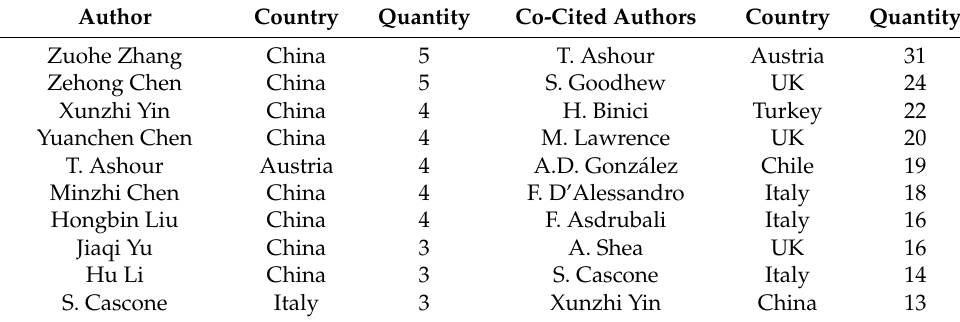
Table 3. Top 10 active and co-cited